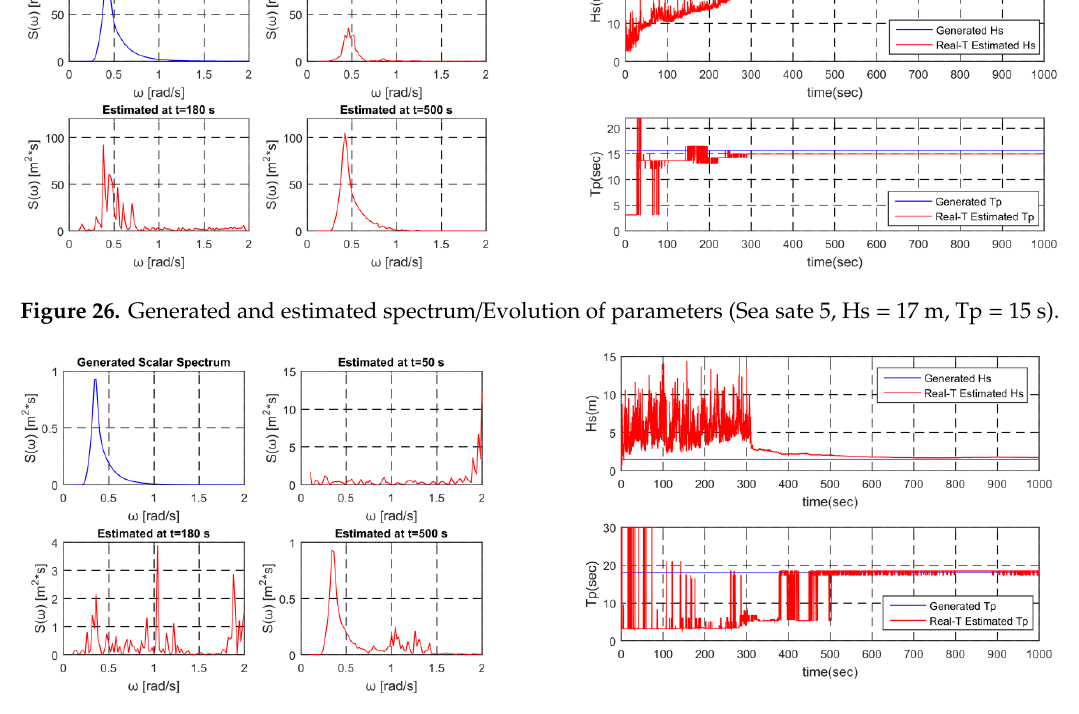
Figure 25. Generated and estimated spectrum/Evolution of parameters (Sea sate 4, Hs = 13 m, Tp = 13 s).